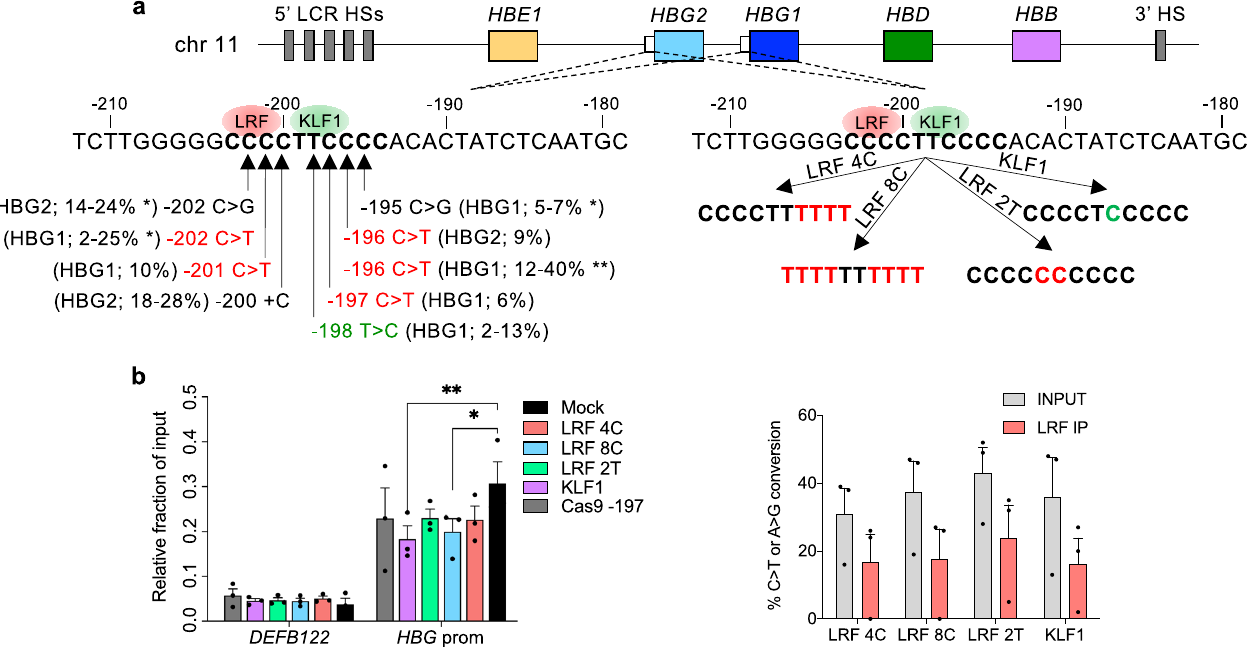
Fig.1|LRFBSdisruptionandKLF1BScreationinthe HBG1/2 promotersinK562 cells. a Schematic representation of the β -globin locus on chromosome